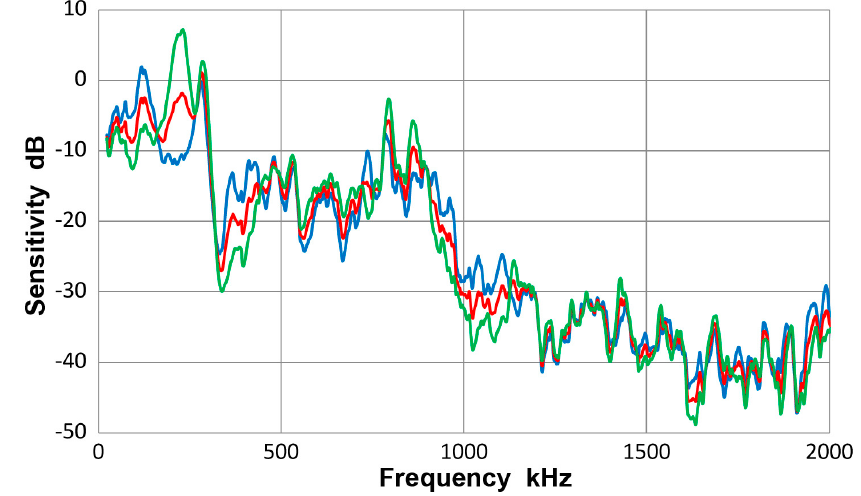
Figure 12. Receiving sensitivity of PAC WD sensor. Red -averaged guided wave sensitivity, blue -Lamb waves for 12.7 and 6.4 mm plates, green -bar waves for 12.7 and 6.4 mm bars.